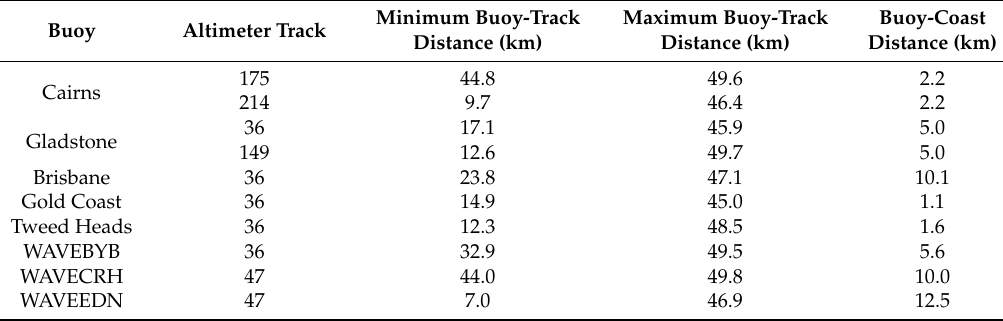
Table 1. Description of buoys and corresponding altimeter